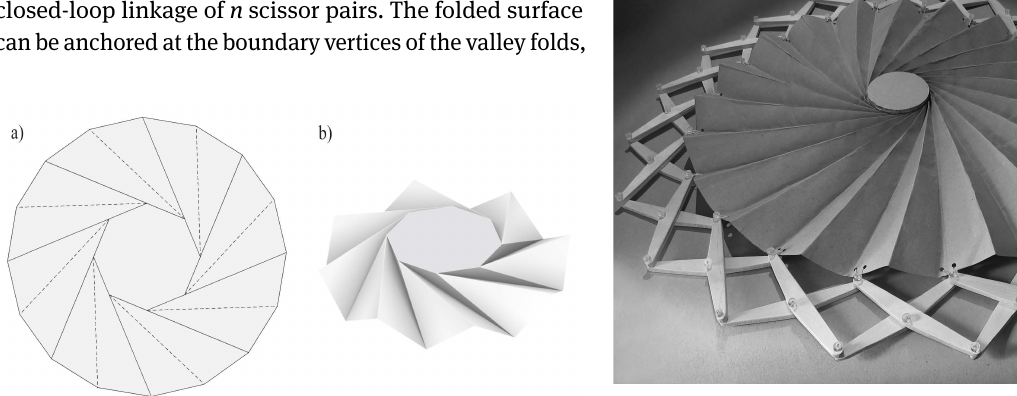
Figure 11: Octagon flasher: a) crease pattern, b) half folded configu- ration